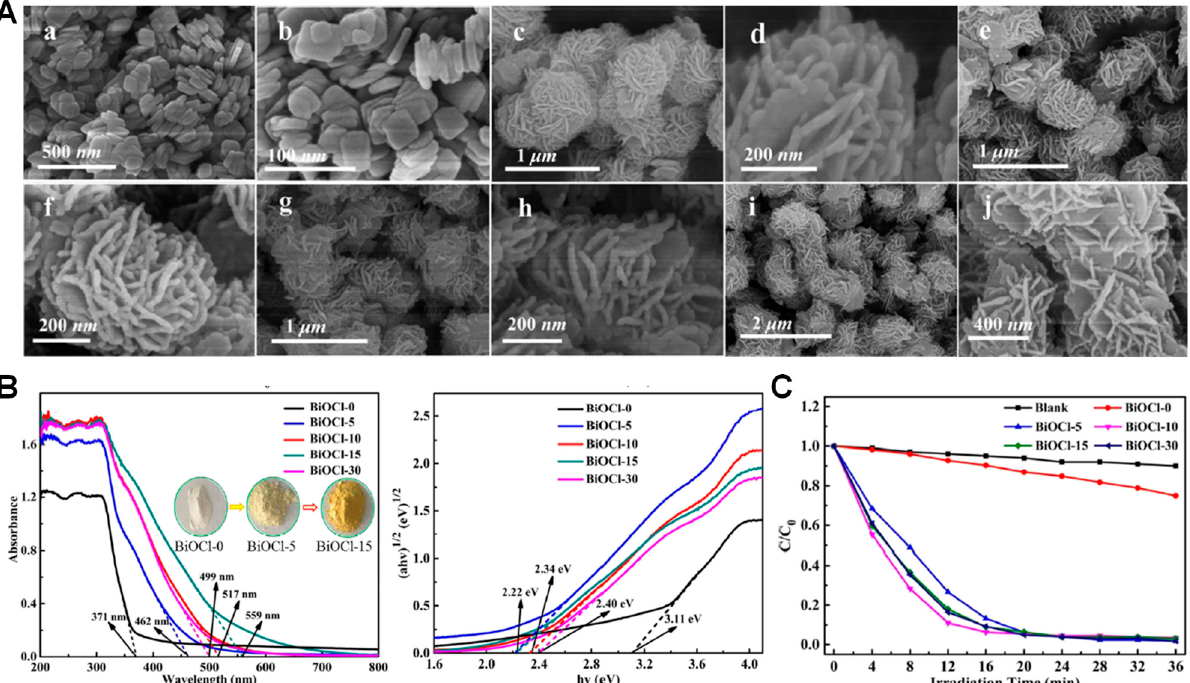
Figure 2. SEM images ( A ), UV-vis DRS ( B ), and photocatalytic dye degradation ability ( C ) of BiOCl NMs synthesized with different amounts of thiourea. For SEM images, BiOCl-0 ( a , b ), BiOCl-5 ( c , d ), BiOCl-10 ( e , f ), BiOCl-15 ( g , h ), BiOCl-30 ( i , j ). Reproduced with permission from Ref. [38], 2019, American Chemical Society.